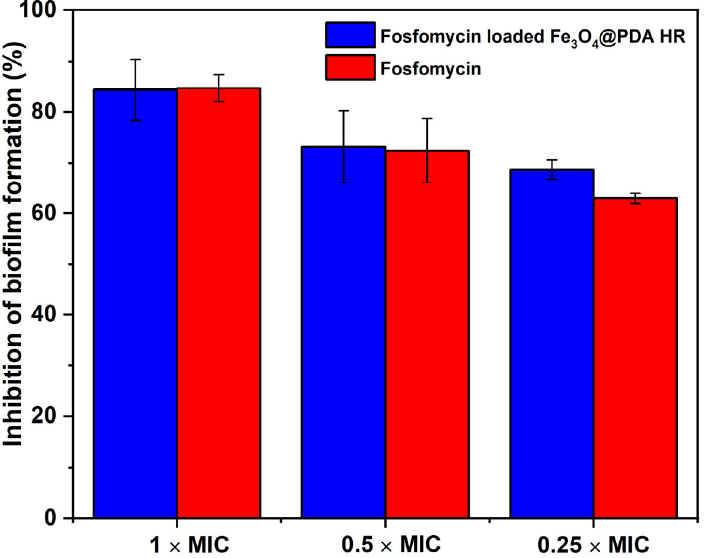
Figure 6. Inhibitory effect on biofilm formation of fosfomycin loaded Fe 3 O 4 @PDA HR and free fosfomycin drug molecules.